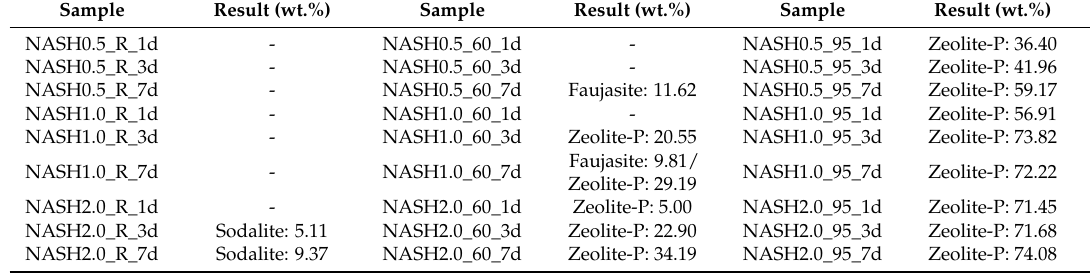
Table 3. Quantitative analysis results of N-A-S-H system using the RIR method. Sample Result (wt.%) Sample Result (wt.%)